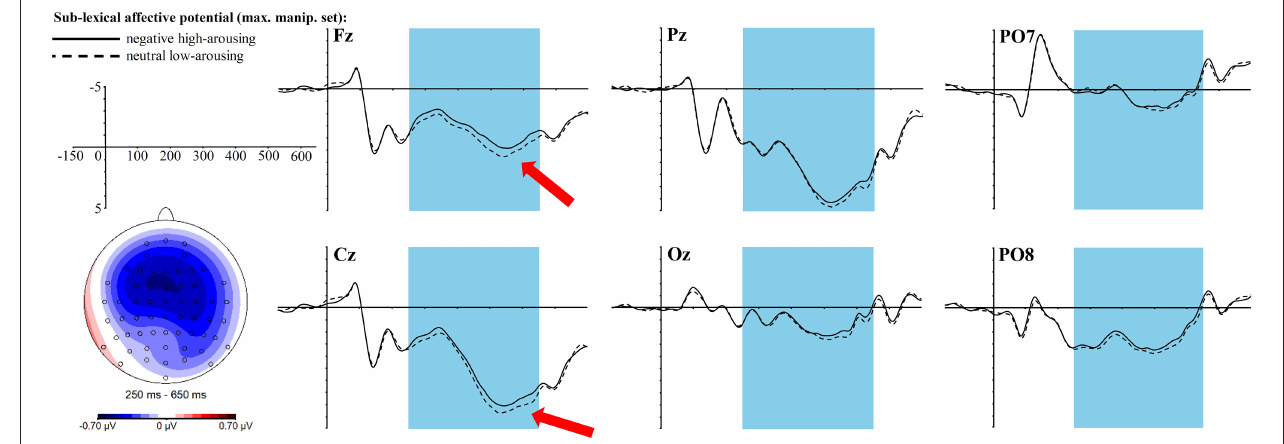
FIGURE 3 | ERP effect of the sublexical affective potential in the maximally manipulated stimulus set at selected electrode sites. The red arrows indicate at which electrodes the effect is most pronounced. For the topographic map sublexically neutral low-arousing words were subtracted from sublexically negative high-arousing